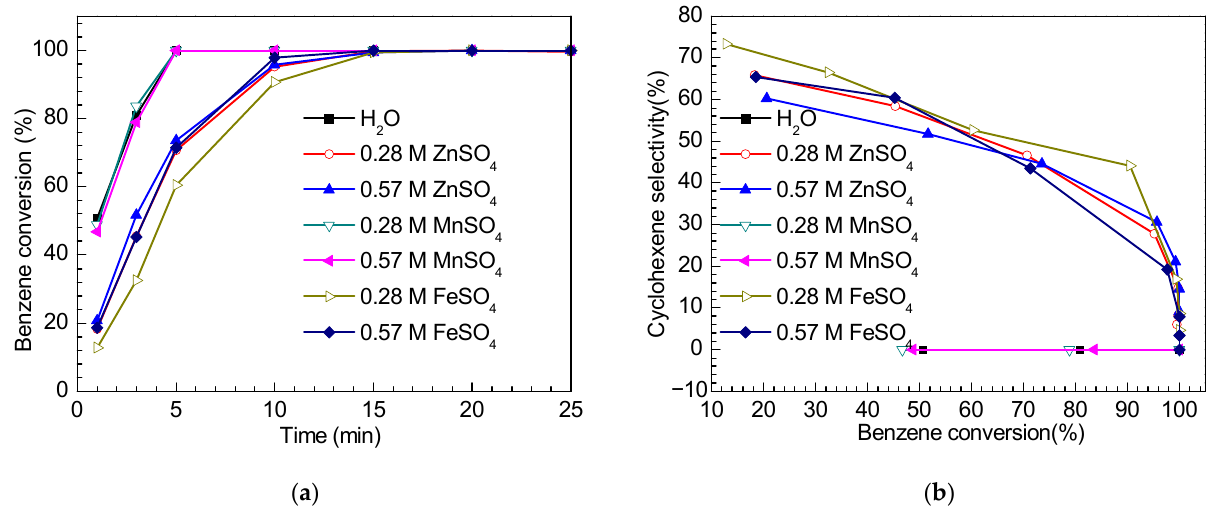
Figure 5. Catalytic activity towards benzene conversion and cyclohexene selectivity over the monometallic Ru catalyst with different reaction modifiers (m cat = 1.8 g, V H2O = 280 mL, V benzene = 140 mL, T = 423 K, p H 2 = 5.0 MPa) ( a ): benzene conversion; ( b ): cyclohexene selectivity.